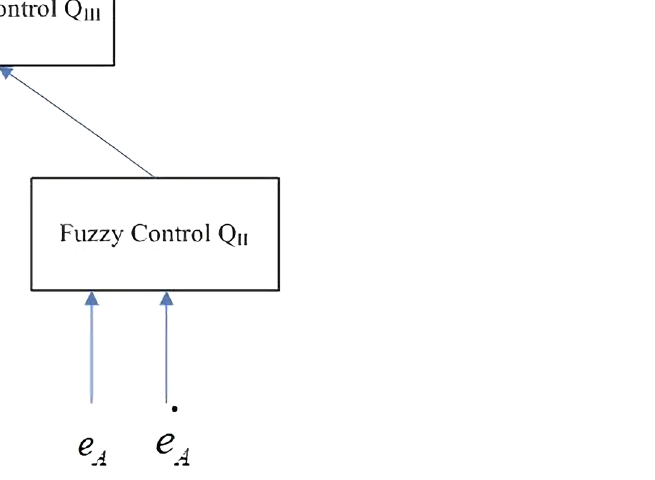
Figure 9. Hierarchical Fuzzy control.